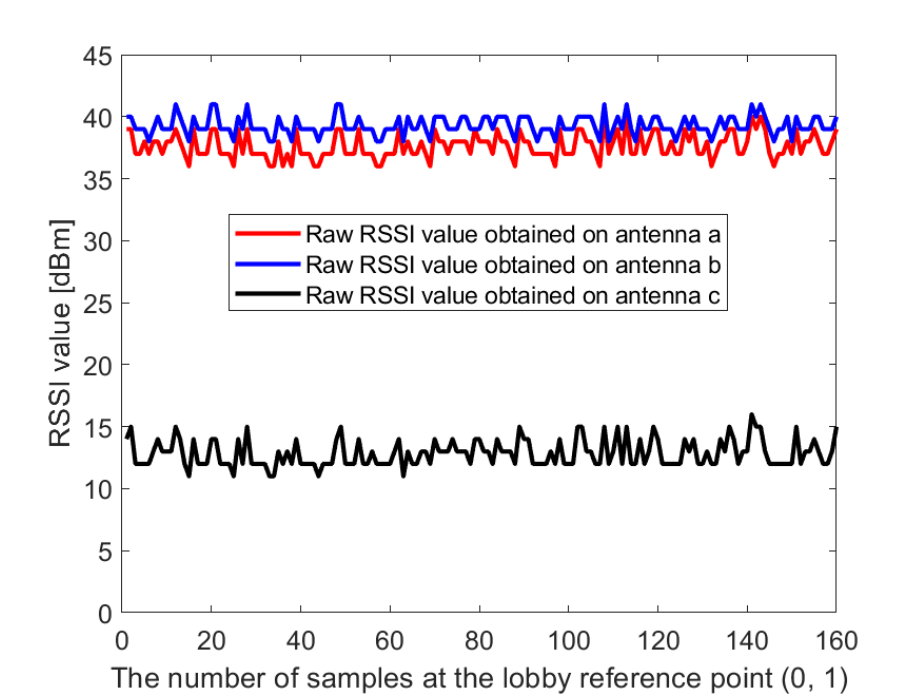
Figure 3. The raw RSSI value of AP1 obtained at the reference point (0,1) in the lobby of IT2